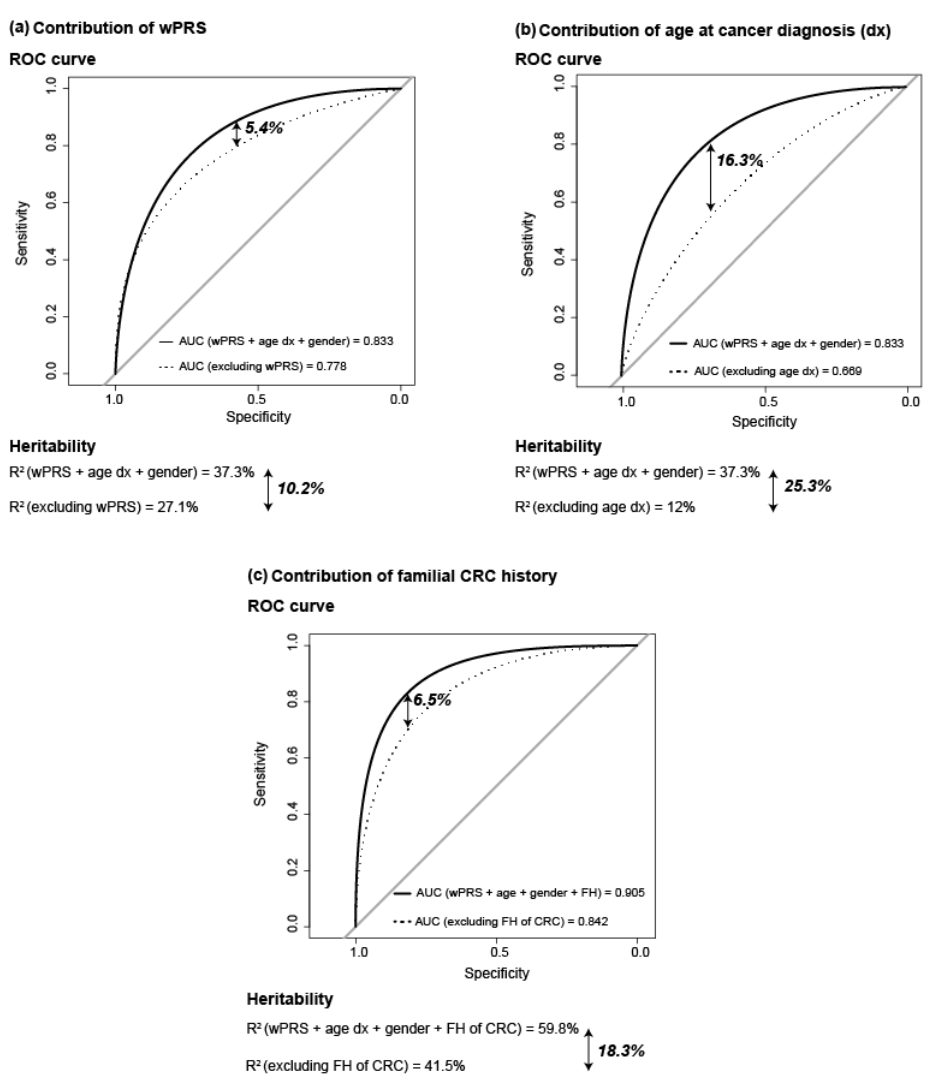
Figure 3. Contribution to Area Under the Curve (AUC) and heritability (R 2 ) of: ( a ) 92-variant wPRS; ( b ) age at cancer diagnosis; and ( c ) familial CRC history. Data from 417 fCRC patients and 1642 controls were considered for ( a , b ) calculations. Due to data availability, data from 405 fCRC and 1094 controls were considered for ( c ) calculations. Abbreviations: AUC, area under the ROC curve; age dx, age at diagnosis; ROC, receiver operating characteristic; wPRS, weighted PRS. Knowing that fCRC corresponds per se to a highly selected population—mainly